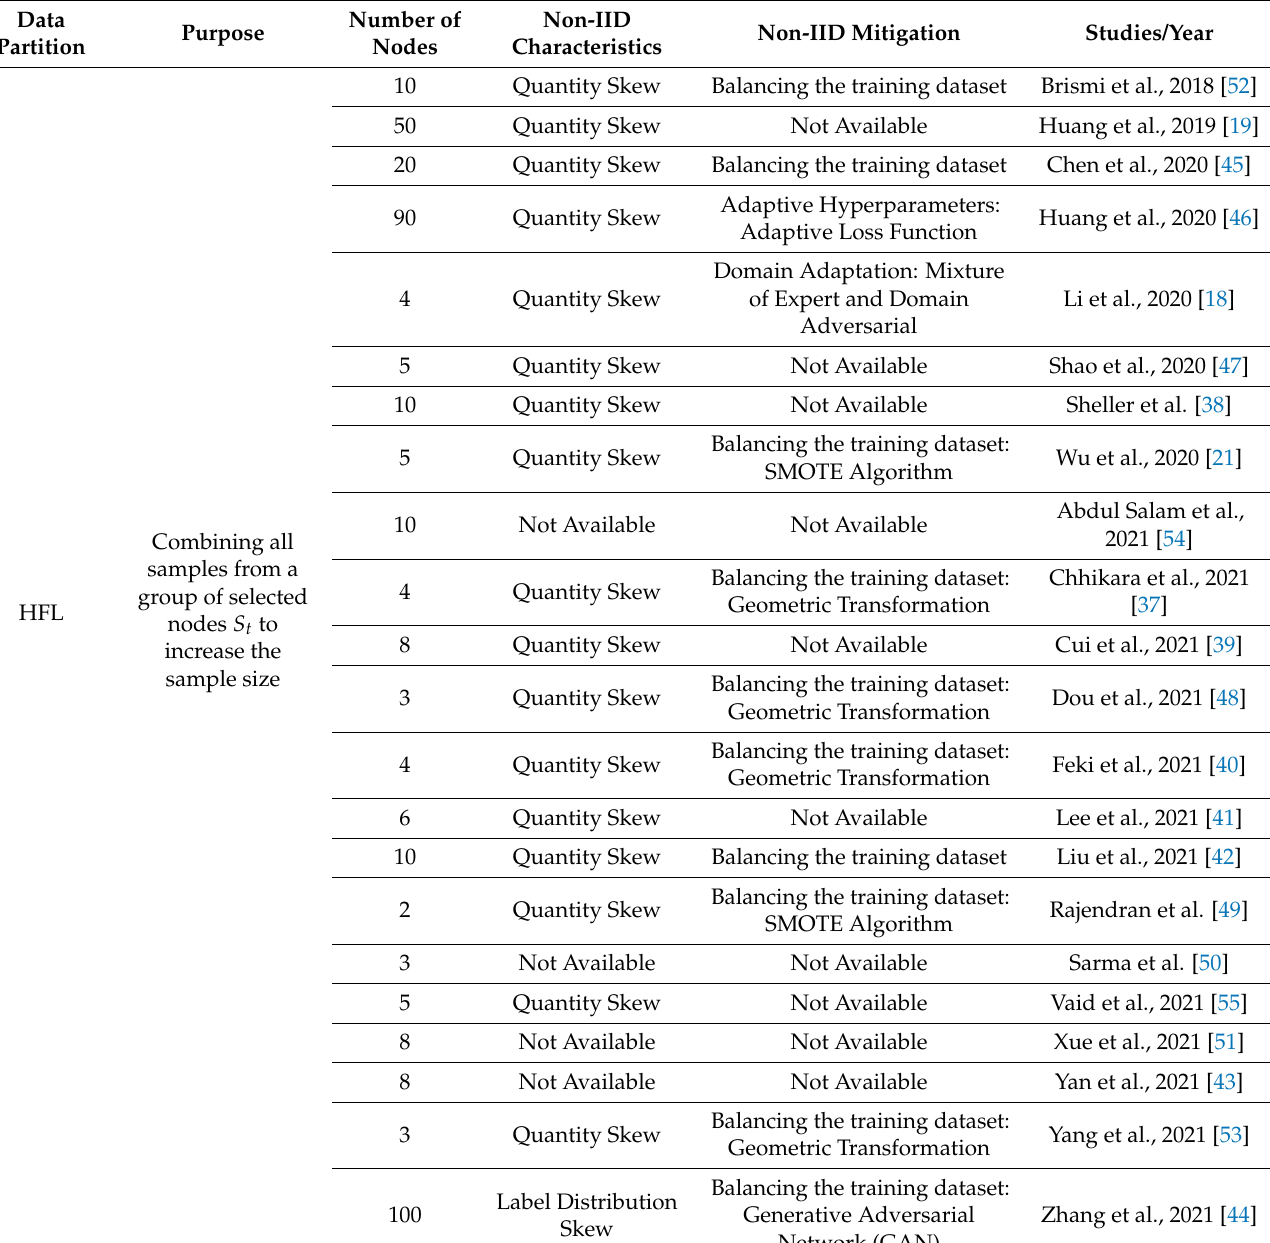
Table 2. Summary of different data partition methods, number of nodes, non-IID characteristics, and non-IID mitigation employed in the published federated learning for healthcare